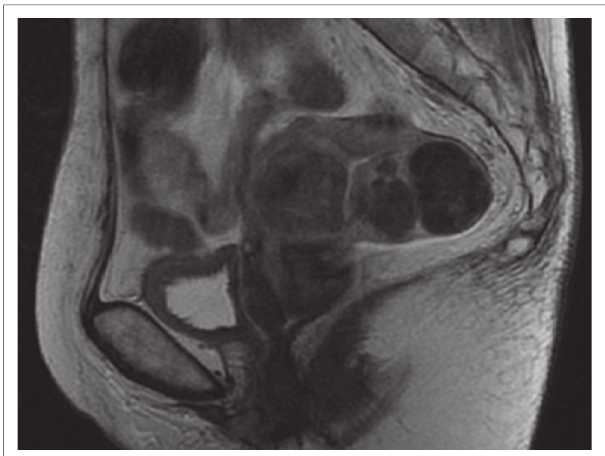
FIGURE 1: Myomatous uterus with diffuse deviation or endometrial deviation.